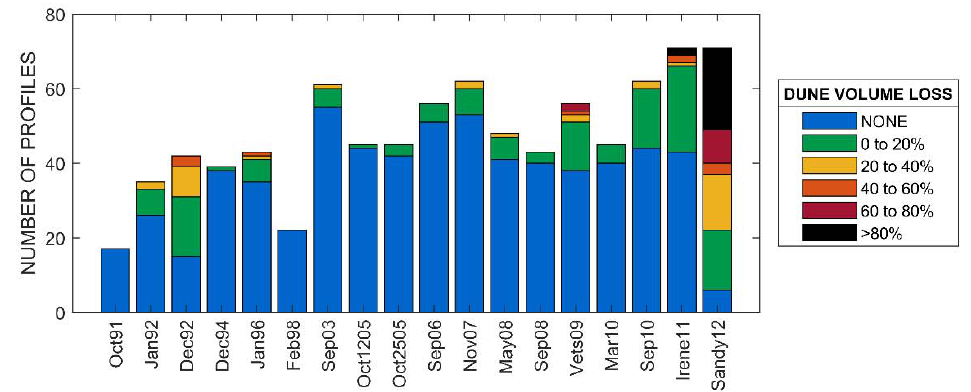
Figure 4. Instances of dune volume loss, as a percentage of pre-storm dune volume, for eighteen storms in New Jersey.